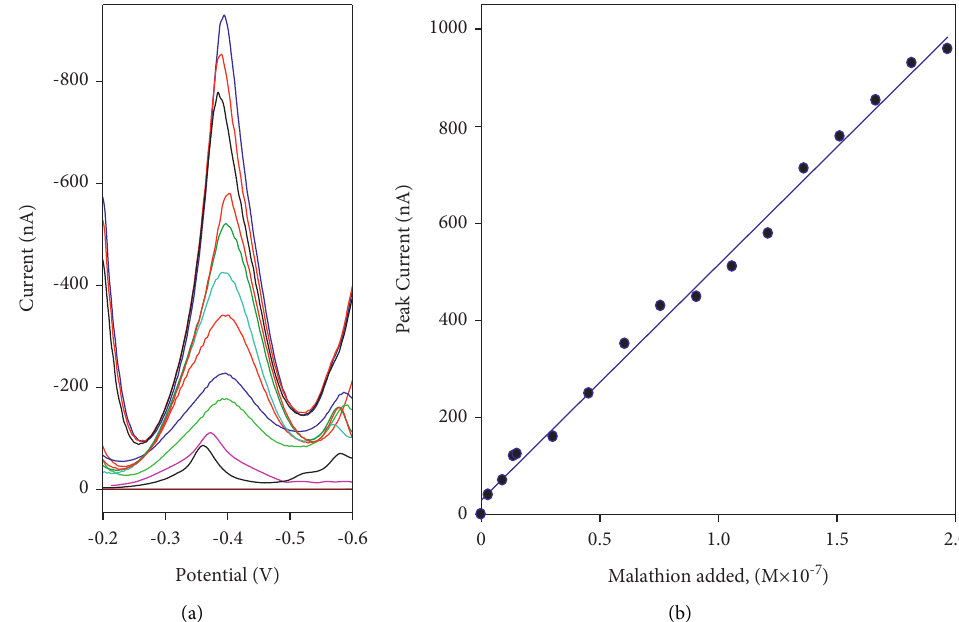
Figure 5: SW-CS voltammograms (a) and the respective linear calibration plot of the cathodic peak current ( i concentration at − 0.42V (b) of malathion and Cu 2+ at pH 2 of peak 1 at HMDE versus Ag/AgCl electrode. Deposition and staring potential −